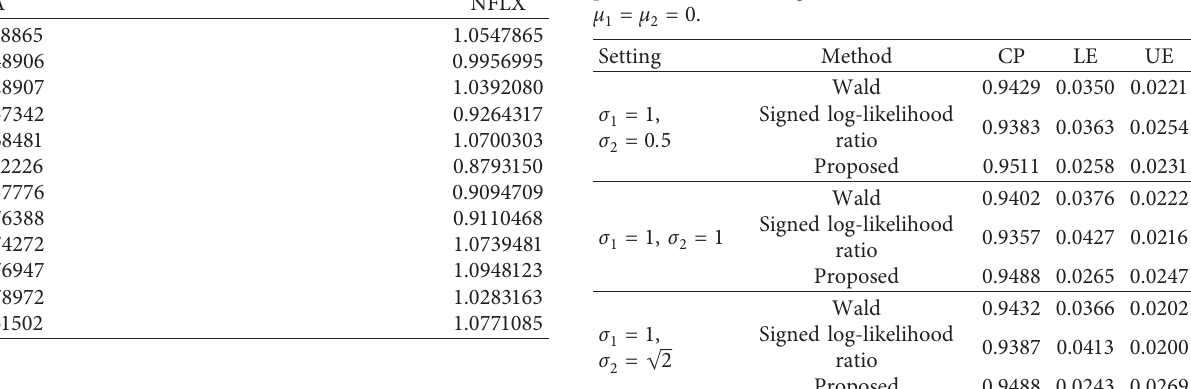
Table 5: Simulation results for two sample Sharpe ratios com- parison under IID lognormal returns for n